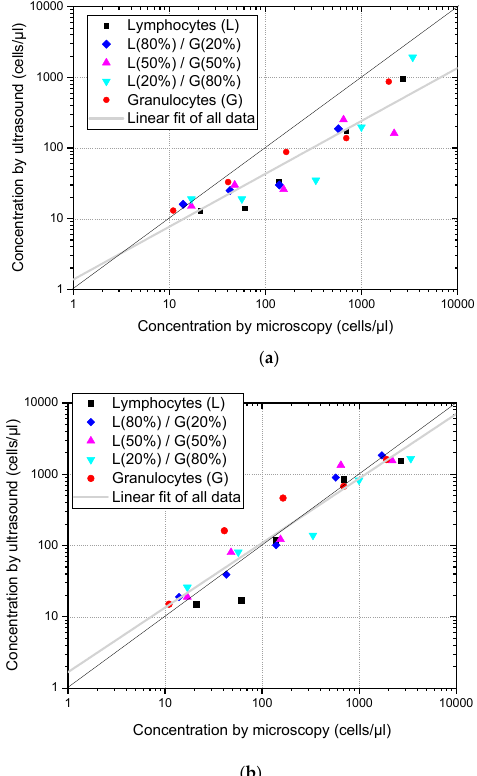
Figure 5. Cell concentration of pure suspensions and mixtures of lymphocytes and granulocytes is estimated from the ultrasound images as a function of the concentration measured using optical microscopy. The diagonal black line corresponds to the concentration coincidence between both methods and the grey line corresponds to the linear fitting of all points. ( a ) Concentration assessment without size dispersion compensation. ( b ) Concentration assessment with size dispersion compensation.